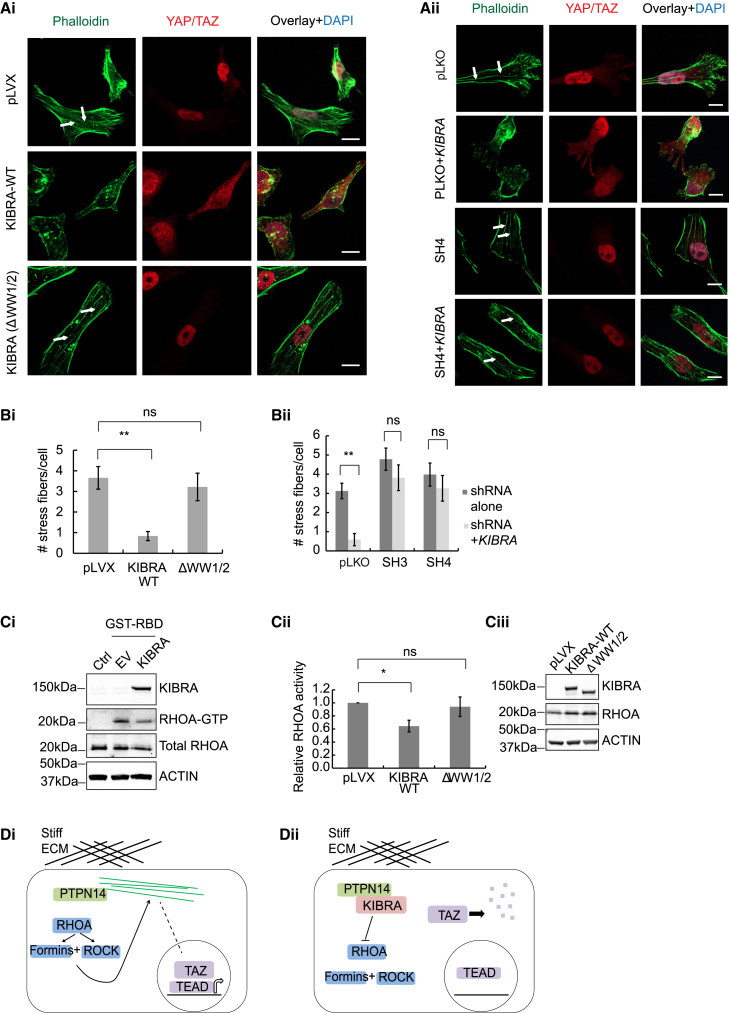
KIBRA and PTPN14 Co-operatively Regulate Actin Cytoskeletal Tension to Inhibit the Nuclear Translocation of YAP/TAZ(Ai) Representative phalloidin staining and YAP/TAZ immunofluorescence of MDA-MB-231 cells expressing empty vector, wild-type KIBRA, or ΔWW1/2 KIBRA seeded on collagen-coated coverslips. White arrows indicate actin stress fibers. Scale bars, 10 μm.(Aii) Representative immunofluorescence as in (Ai) for cells expressing pLKO control or shPTPN14 (SH4) with or without KIBRA.(Bi and Bii) Number of stress fibers per cell for (Ai) and (Aii) (n = 3, mean ± SEM).(Ci) Representative Rhotekin-GST pull-down in MDA-MB-231 cells expressing EV or KIBRA. GST alone was used as a control (Ctrl).(Cii) RHOA activity determined by G-LISAs (n = 3, mean ± SEM).(Ciii) RHOA protein levels for (Cii).(D) Schematic diagram showing regulation of TAZ by KIBRA.(Di) In the absence of KIBRA, stiff ECM activates RHOA, leading to actin stress fiber formation and contractility, facilitating TAZ nuclear translocation and interaction with TEA-domain (TEAD) transcription factors to promote expression of pro-oncogenic genes.(Dii) Association of KIBRA with PTPN14 inhibits RHOA activation required for actin stress fiber assembly, removing the stimulus for nuclear translocation of TAZ and resulting in its proteasomal degradation.See also Figure S7.